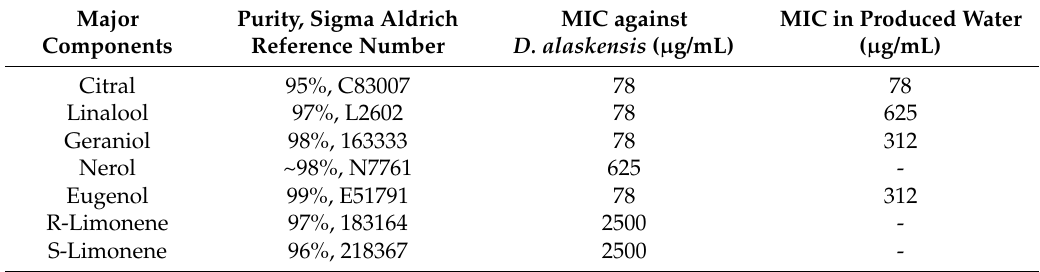
Table 3. Determination of the minimum inhibitory concentration (MIC) of commercially-available major components of EO against Desulfovibrio alaskensis NCIMB 13491 and against SRB growth in produced water